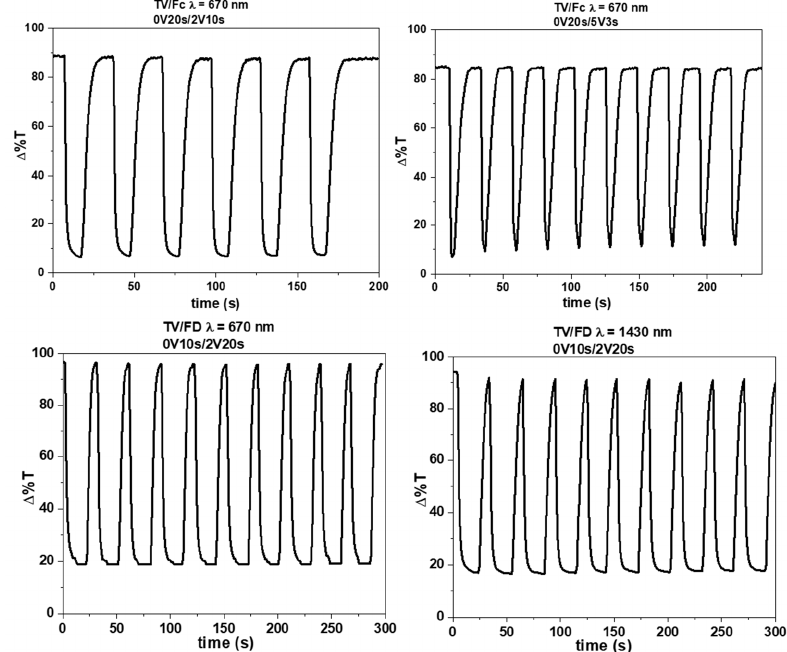
Figure 2. Representative Vis and NIR switching cycles of the devices showing the ∆ %T as a function of the potential difference applied. The wavelengths at which the transmittance was measured and the switching pulse sequence are labeled on each panel.